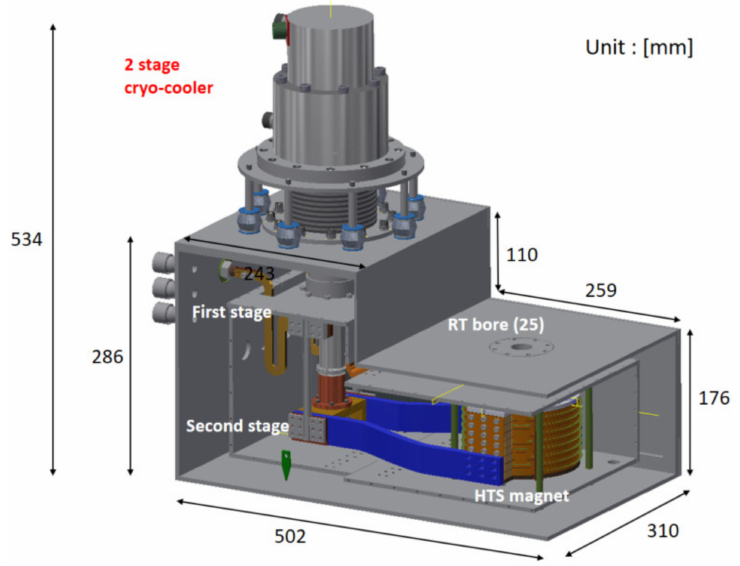
Figure 1. Drawing of the 3 T HTS electromagnetic property measurement system